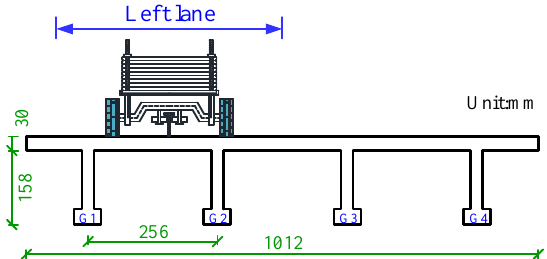
Figure 14. Bridge section and loading position.